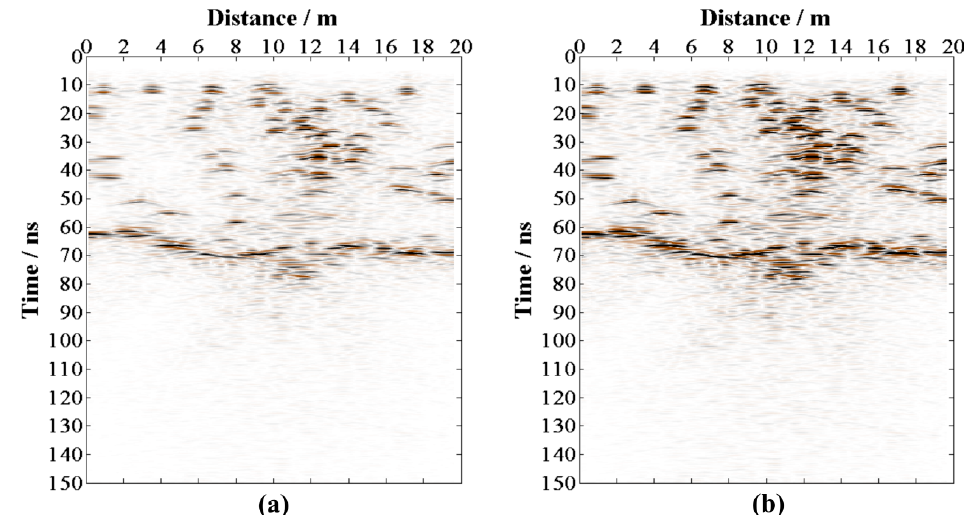
Figure 7. Demonstration of dip filter results in two datasets with different offsets.